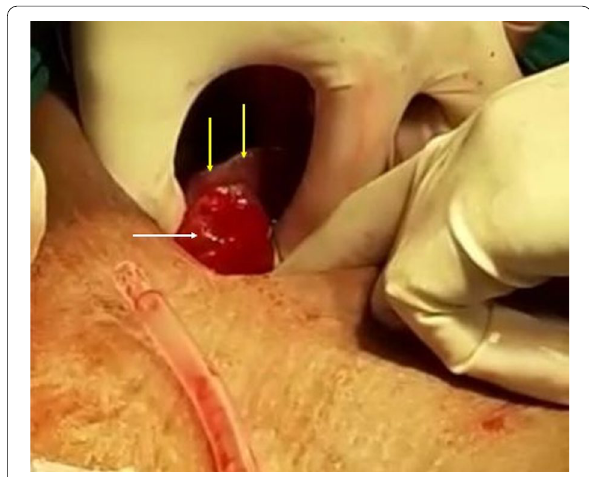
Fig. 4 Intraoperative image showing gestational sac (white arrow) attached to the inferior surface of Segment VI of liver (yellow